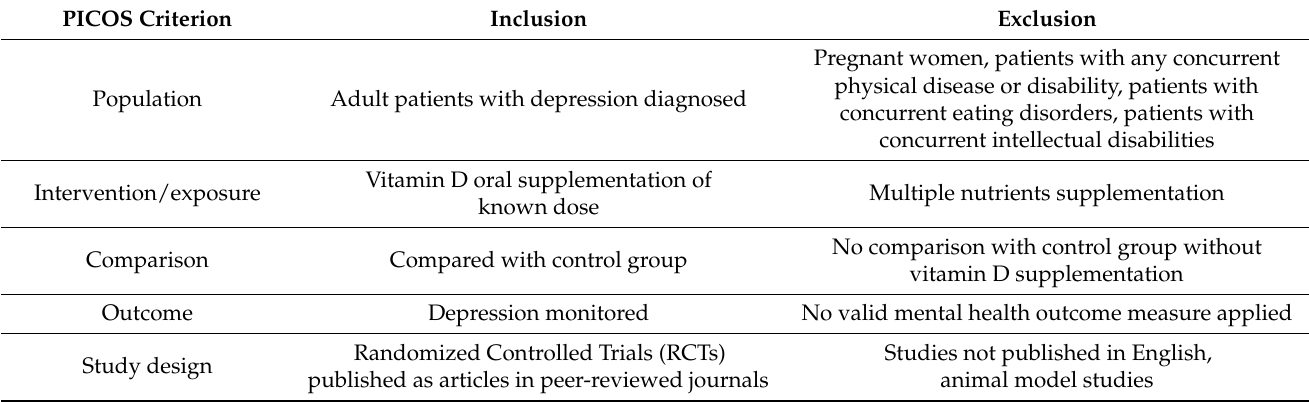
Table 1. The patient, intervention/exposure, comparator, outcome, and study design (PICOS)